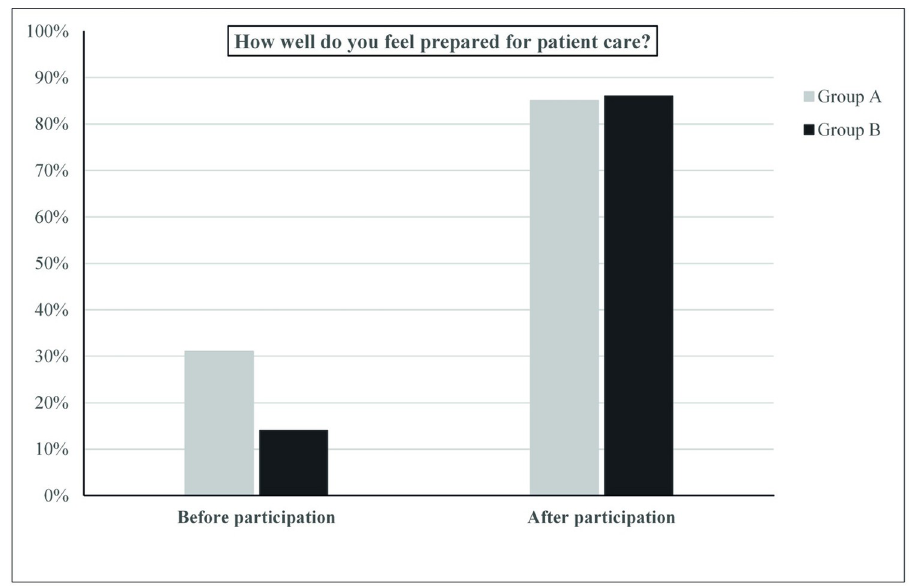
Fig 1. Graphical representation of the question how well prepared the participants felt for patient care before and after taking part in the course. Before joining the course, 31% of participants with previous experience with computer simulators (group A) and 14% of participants without previous experience with computer simulators (group B) indicated that they felt well prepared for patient care. Afterwards, 85% of group A, and 86% of group B agreed with this statement. There was a significant difference before and after participation in this course within both groups (Group A: p = 0.008, group B: p = 0.001). https://doi.org/10.1371/journal.pone.0264180.g001 to be important by 77% (71% of the participant group, 100% of the tutor group, p = 0.161) and training on computer simulators by 100% of both groups. We found a significant difference within the group of participants (p = 0.008), when we compared how important they assessed the training on silicone models or computer simulators before doing thrombectomies in humans. Table 3. Illustration of the statistical evaluation of the received questionnaires. Participant/tutor indicated that Total Participant